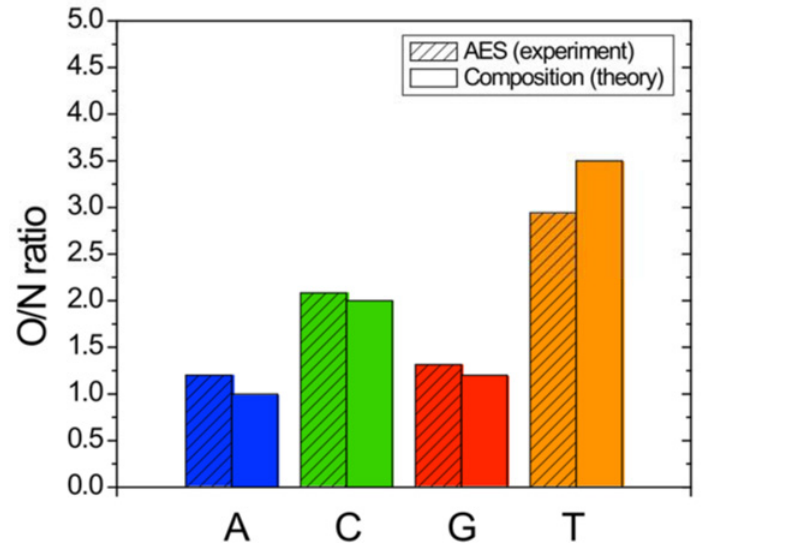
doi:10.1371/journal.pone.0154707.g007